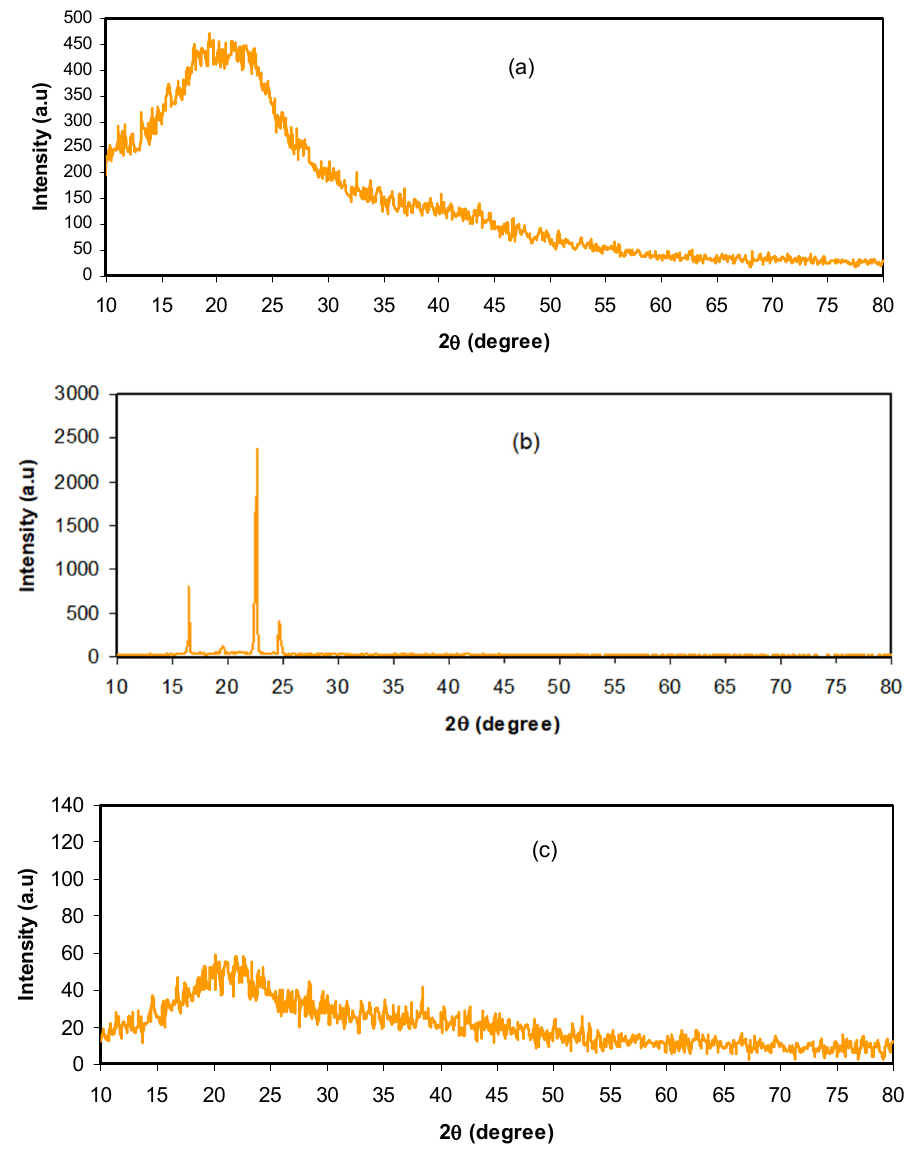
Figure 1. XRD spectra for the ( a ) pure chitosan (CS): dextran (DX), ( b ) CSDNHP1, and ( c ) CSDNHP3 electrolyte films.